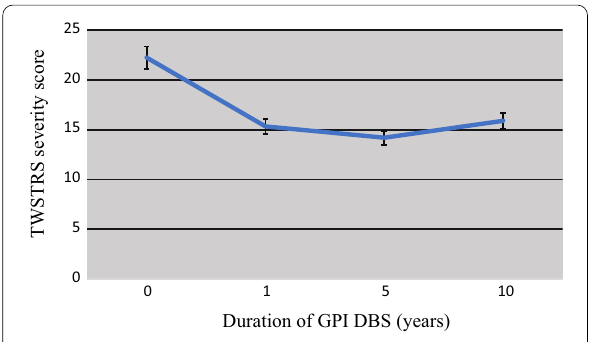
Fig. 2 Course of TWSTRS severity score over 10 years in patients treated with GPI DBS